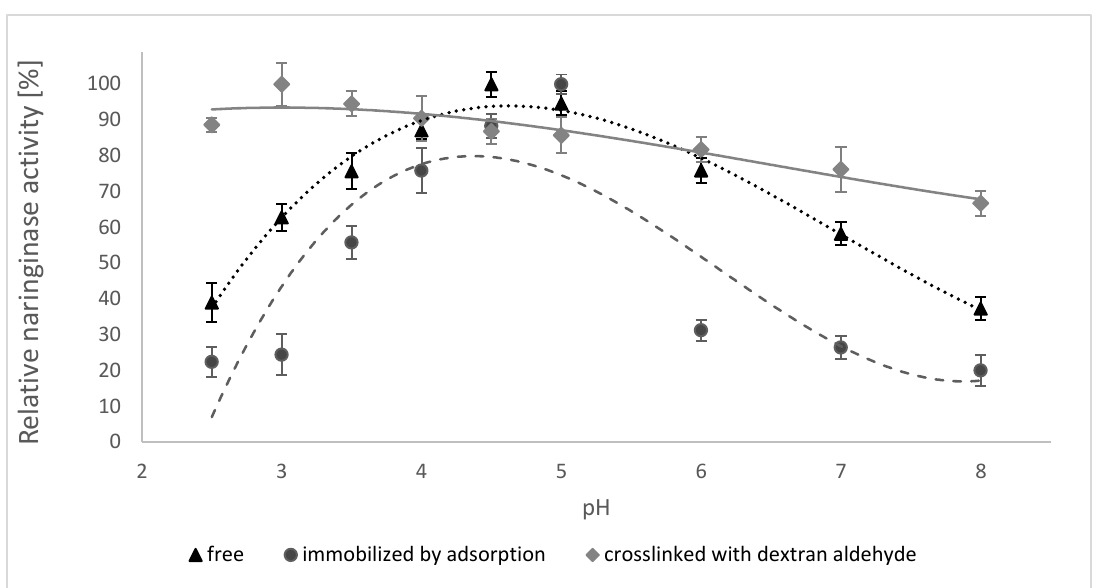
Figure 4. Stability of free, adsorption-immobilized and crosslinked naringinase from A. niger KMS depending on the pH of the environment. Activity of free naringinase (100% = 411 µmol min −1 g −1 of the preparation); Activity of naringinase immobilized by adsorption (100% = 16.72 µmol min −1 g −1 of the carrier); Activity of crosslinked naringinase with dextran aldehyde (100% = 16.69 µmol min −1 g −1 of the carrier). The activity of enzymes was determined at 50 °C, pH 4.0.